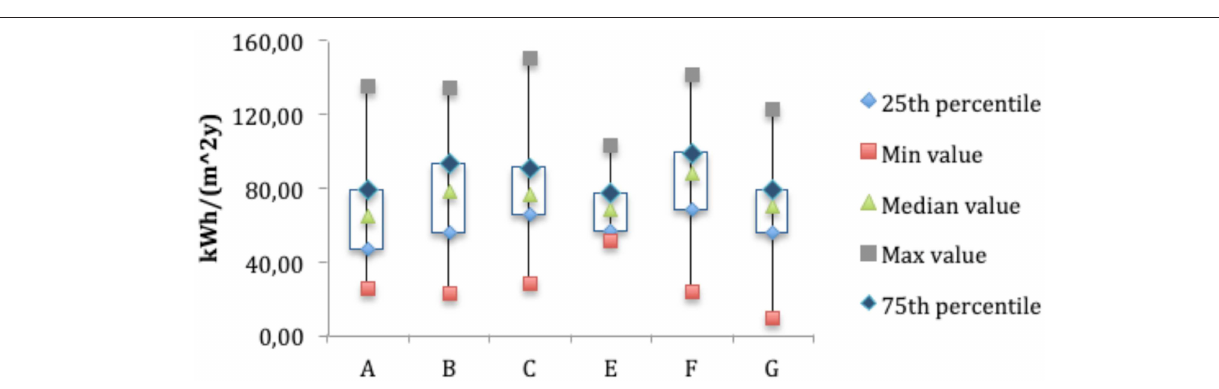
FIGURE 4 | Actual thermal energy consumption for heating (2017 October 15th − 2018 April